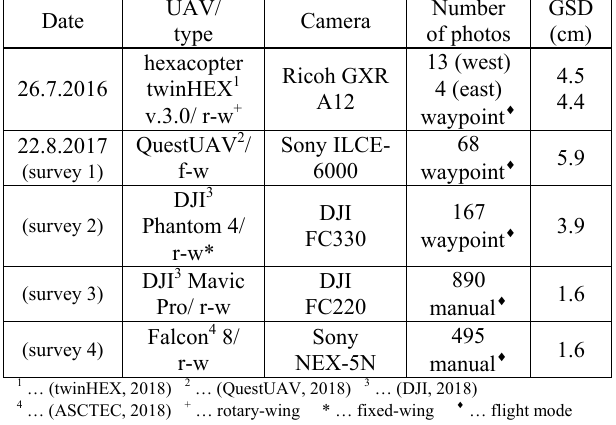
Figure 4. Geodetic measurement (RTK-GNSS) of a GCP close to the frontal slope on